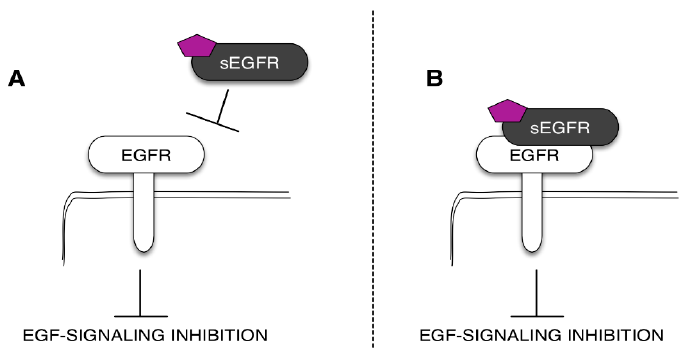
Figure 3. Mechanisms of the sEGFR isoform anti-tumoral action. The sEGFR can avoid the ligand-dependent EGFR activation sequestering the ligand (purple pentagon) ( A ) or directly binding the EGFR ECD ( B ).